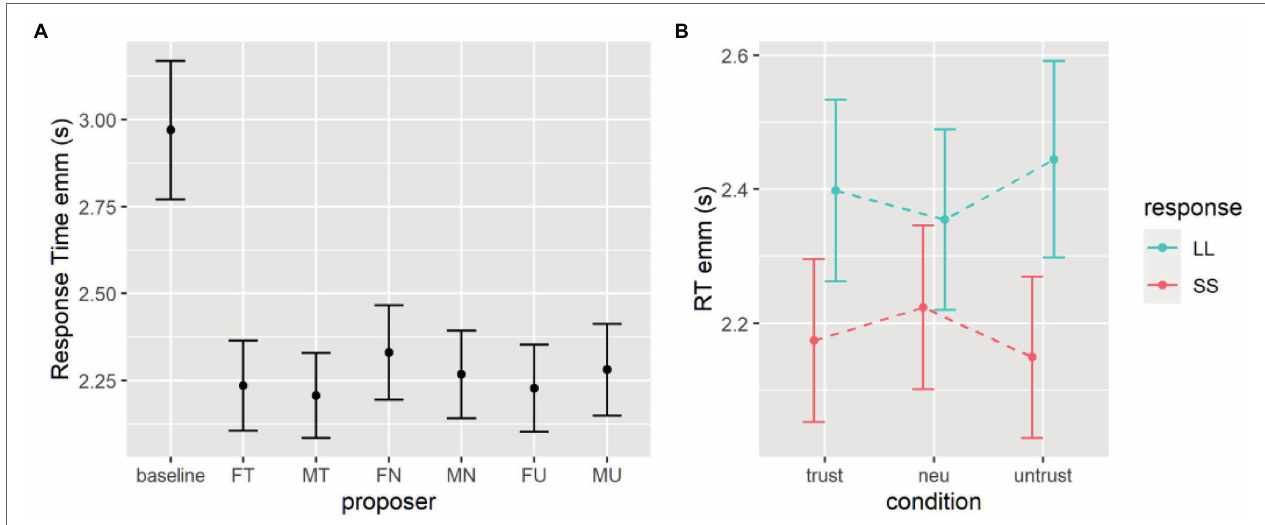
FIGURE 4 | Estimates for response times in the delay discounting task with masked proposers. (A) Estimates from the first model, with baseline data. (B) Estimates from the second model, without the baseline data. SS, smaller sooner option; LL, larger later